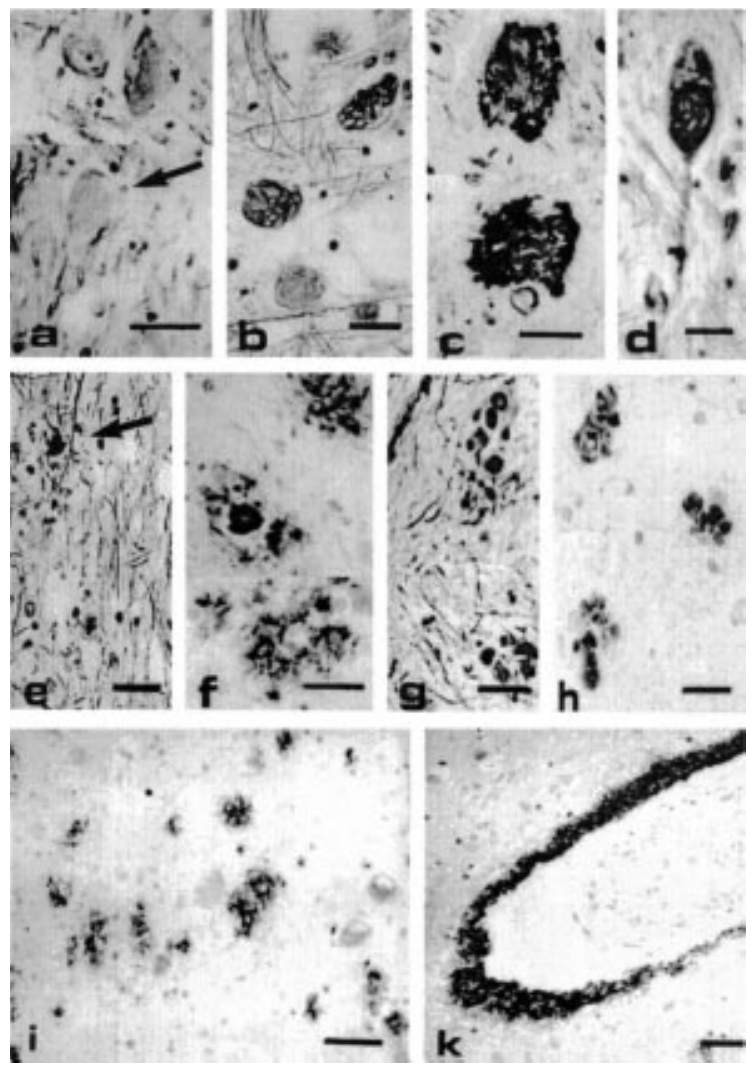
Fig. 3. AD: Histologic findings in the aminergic brainstem nuclei: (a) Degenerating large neurons in the nucleus centralis superior, pars medialis (NCS) with plurivacuolar change akin to granulovacuolar degeneration and neuronal achromasia (arrow, Klüver-Barrera); (b, c) tangle neurons in the NCS (b) and in the LC (Bodian) (c); (d) NCS neuron with tangles containing a round cytoplasmic inclusion body (Bodian); (e) core plaque (arrow, Bodian) and diffuse plaques; (f) immunolabeled with mAb W 0 (cid:0) 2 to (cid:12) /A4 amyloid protein in the NCS; (g, h) neuritic plaques with dystrophic axons in the NCS ((g) Bodian, (h) immunoreaction with mAb 22c11 to APP); (i) NCS: amorphous plaques (preplaques); and (k) vascular amyloid labeled with the mAB W 0 (cid:0) 2 . (Calibration bars represent 50 (cid:22) m in a, h, i, k, and 25 (cid:22) m in